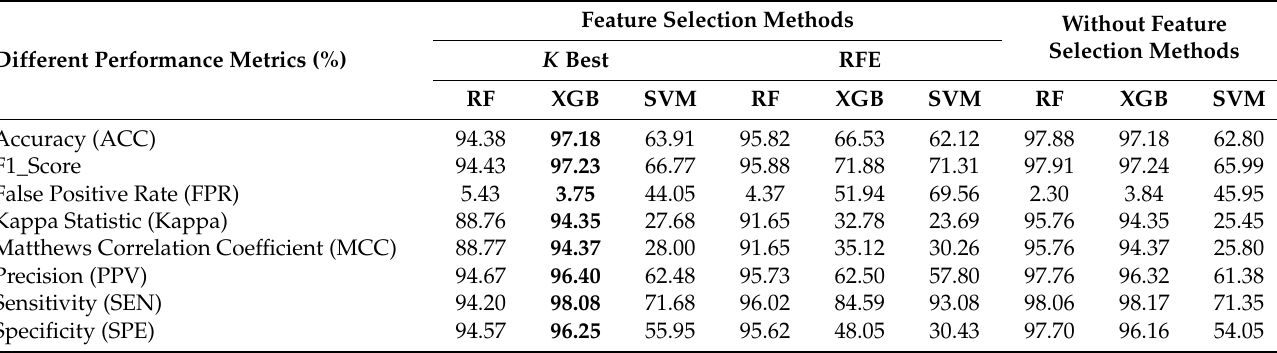
Table 3. Classification performance of different classifiers using RFE, select K Best, and without feature selection. The model’s performances have been proven by comparing several metrics like accuracy, F1_score, Kappa, and more. On K Best feature, best model performances (Accuracy, Precision, Sensitivity, Specificity) accomplished by